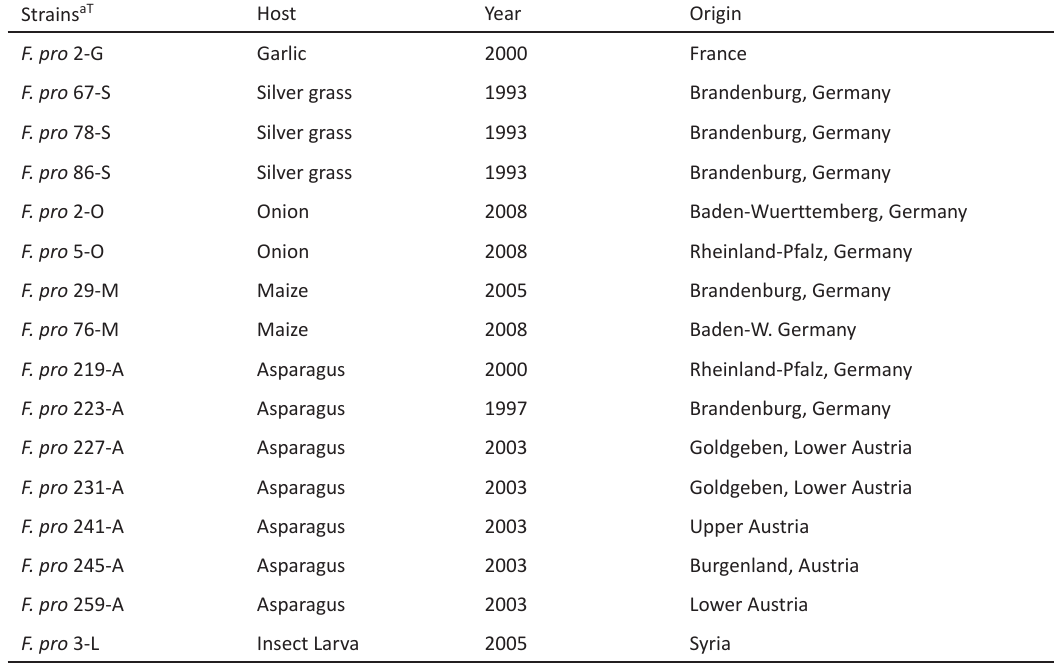
Table 1. F. proliferatum